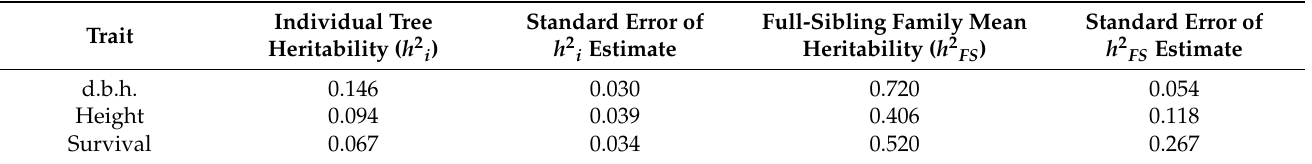
Table 8. Heritability estimates for d.b.h., height, and survival across 15 progeny tests of shortleaf pine on the Ouachita and Ozark-St. Francis National Forests.